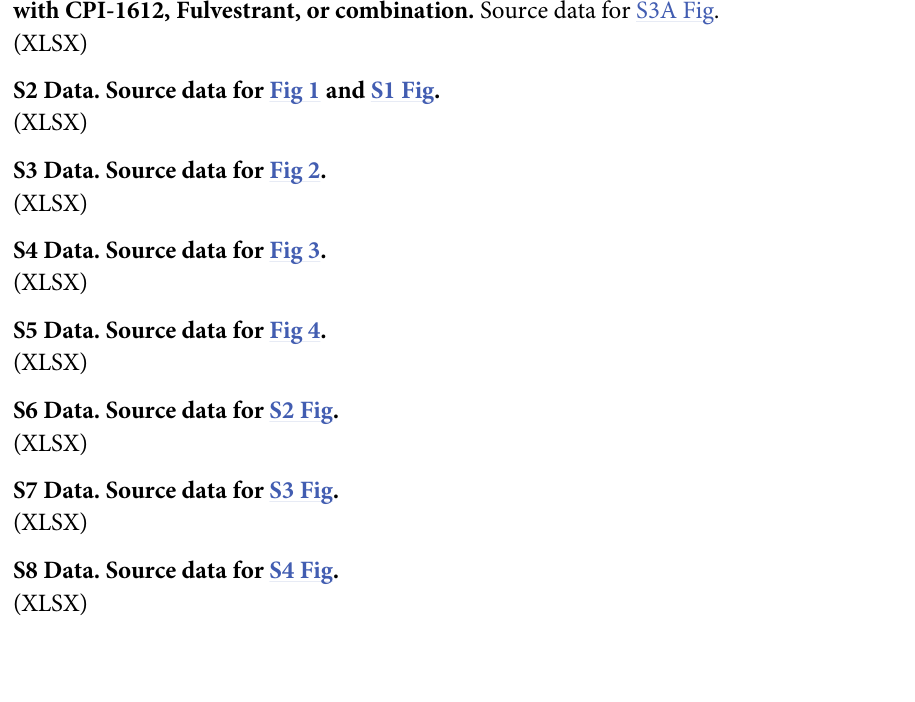
(TIF) S5 Fig. Supplement to Fig 3. Western blot of MCF7 cells treated with DMSO, CPI-1612 (0.1 μ M), Fulvestrant (1 μ M), or Tamoxifen (1 μ M) for 24 or 96 hours and probed with the indicated antibodies. (TIF) S6 Fig. Supplement to Fig 4. A, HOMER motif search of differential H3K27ac peaks upon CPI-1612 treatment. Binding sites for FOXA1 and luminal specific TFs are not enriched in dif- ferential H3K27ac peaks relative to all H3K27ac peaks. B, Overlap of transcription factor (TF) binding with all identified ATAC-seq peaks or those peaks that showed at least a 2-fold reduc- tion in signal after CPI-1612 treatment. ER and FOXA1 data are as described in Fig 4C . (TIF) S7 Fig. Single cell ATAC-seq after CPI-1612 treatment in MCF7 cells. A, UMAP dimensionality reduction plot of scATAC-seq data colored by treatment for both unintegrated cells and data integrated using Harmony. B, Waterfall plot of peaks identified from scATAC- seq data ranked by log (fold-change) for CPI-1612 relative to DMSO. Blue, peaks reduced by 2 at least 2-fold. C, UMAP plot as in A, colored by predicted FOXA1 activity based on Chrom- VAR analysis. D, Quantification of predicted FOXA1 activity for DMSO and CPI-1612 treated cells. Boxplots depict median and range of FOXA1 (MA0148.4 motif) activity; p-value was cal- culated with the Mann-Whitney U test. (TIF) S8 Fig. Supplement to Fig 4. A, Differential expression of genes in the Bas-ECJ or Lum(M)- ECJ gene sets upon treatment with CPI-1612. B, Volcano plot of gene expression changes as described in B . (TIF) S1 Data. RNA-seq differential expression data for MCF7, T47D, and ZR751 cells treated with CPI-1612, Fulvestrant, or combination. Source data for S3A Fig. (XLSX) S2 Data. Source data for Fig 1 and S1 Fig. (XLSX) S3 Data. Source data for Fig 2. (XLSX) S4 Data. Source data for Fig 3. (XLSX) S5 Data. Source data for Fig 4. (XLSX) S6 Data. Source data for S2 Fig. (XLSX) S7 Data. Source data for S3 Fig. (XLSX) S8 Data. Source data for S4 Fig.